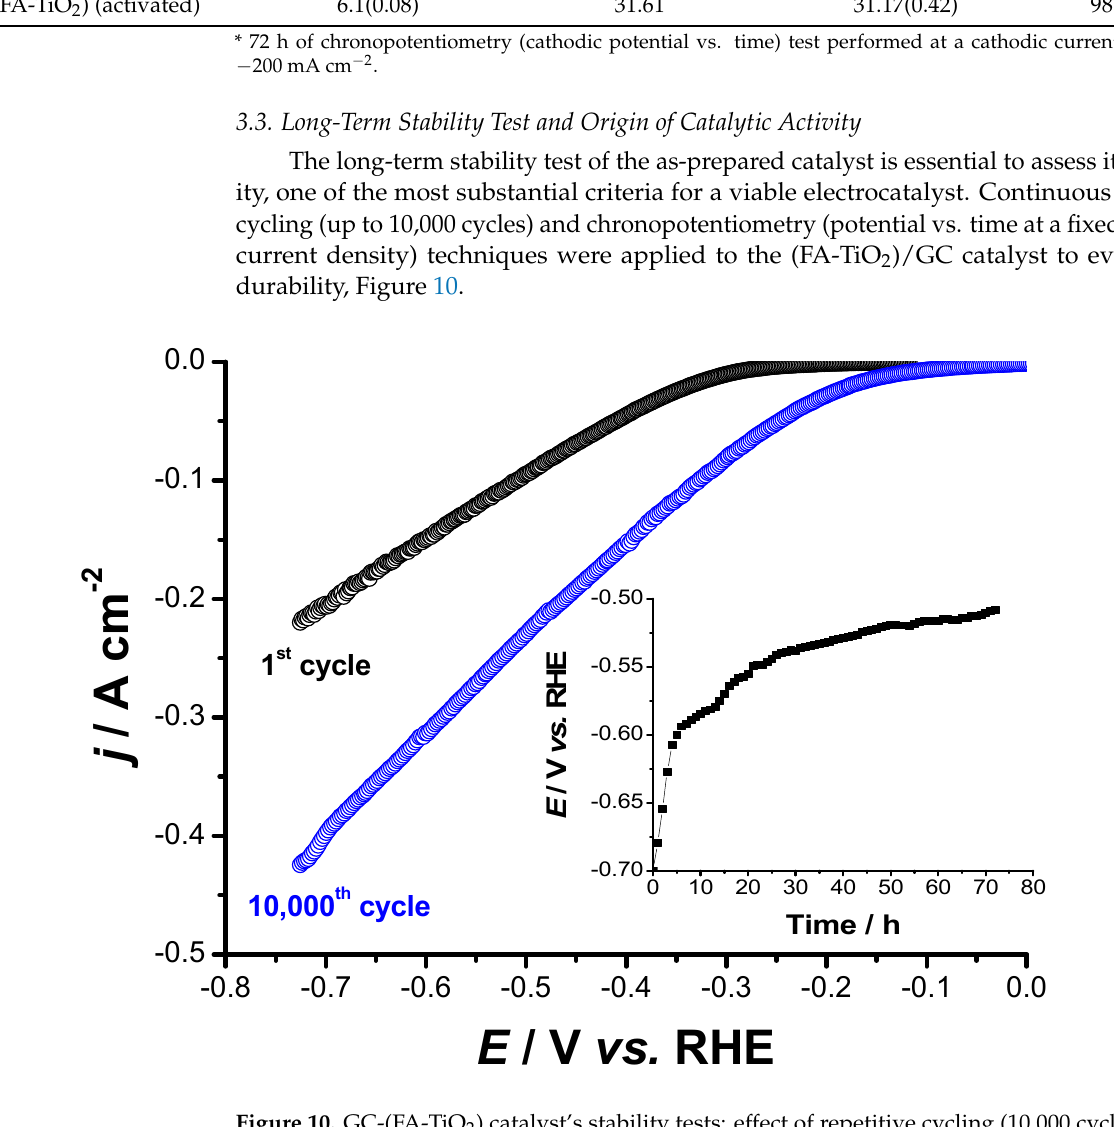
Figure 10. GC-(FA-TiO 2 ) catalyst’s stability tests: effect of repetitive cycling (10,000 cycles)—inset: 72 h of chronopotentiometry (cathodic potential vs. time) test performed at a cathodic current density of − 200 mA cm − 2 . All measurements were conducted in deaerated 0.1 M KOH aqueous solutions at 25 °C.